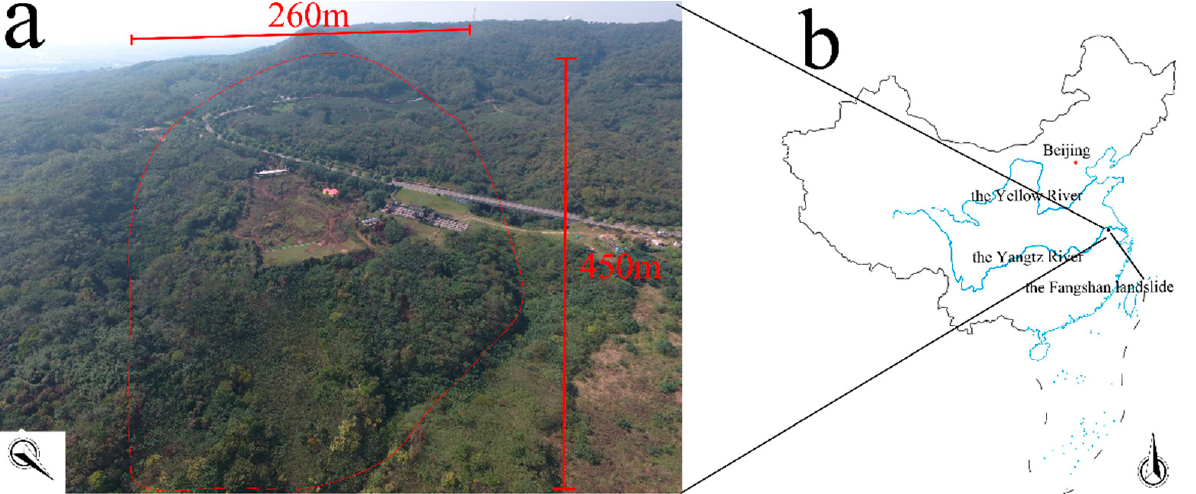
Figure 1. ( a ) Aerial image of the 3 November 2016, Fangshan landslide; ( b ) location of Fangshan landslide. The base map of China is from the standard map, review number: GS (2016) 1549.